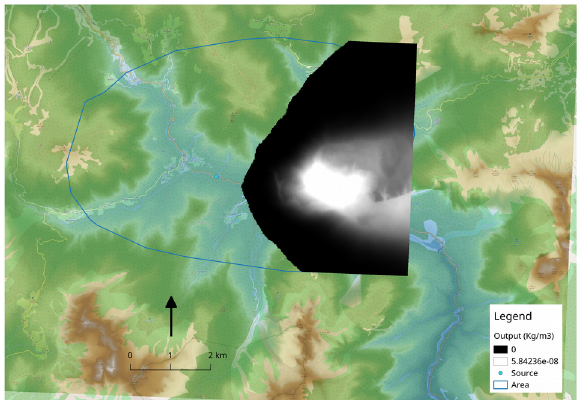
Figure 4. Example of output for the atmospheric module; pollutant ground concentration is evaluated for the area inside the black line for a 80 m chimney releasing 11 Kg/h of